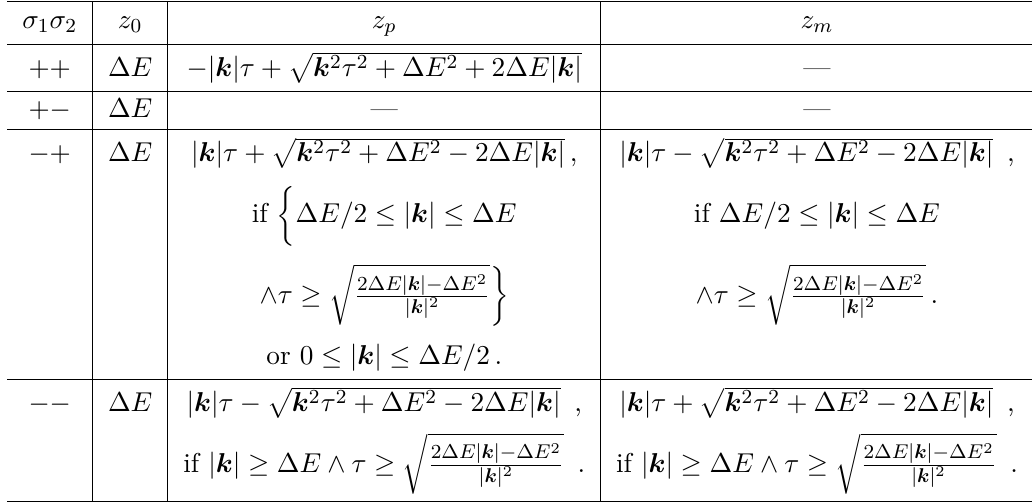
z 0 ) poles, as well as their existence p/m ) and double (